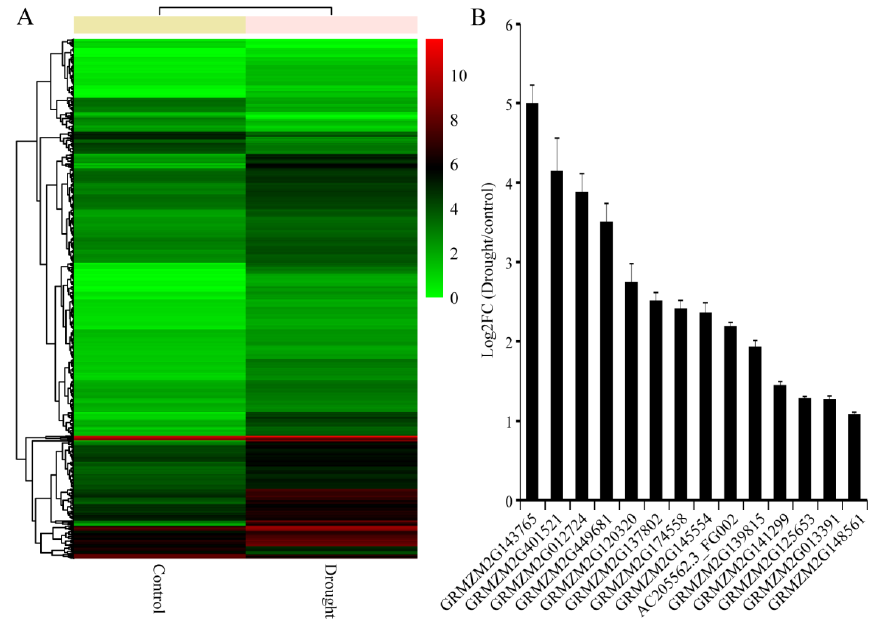
Figure 1. De novo transcriptome sequencing analysis of maize under drought stress. ( A ) Cluster analysis of the differentially expressed genes (DEGs) under drought treatment. ( B ) Transcription levels of the 14 differentially expressed ZmWRKYs under drought treatment. Error bar represent standard deviations (SD). The data represent means ± SD of three biological replications.